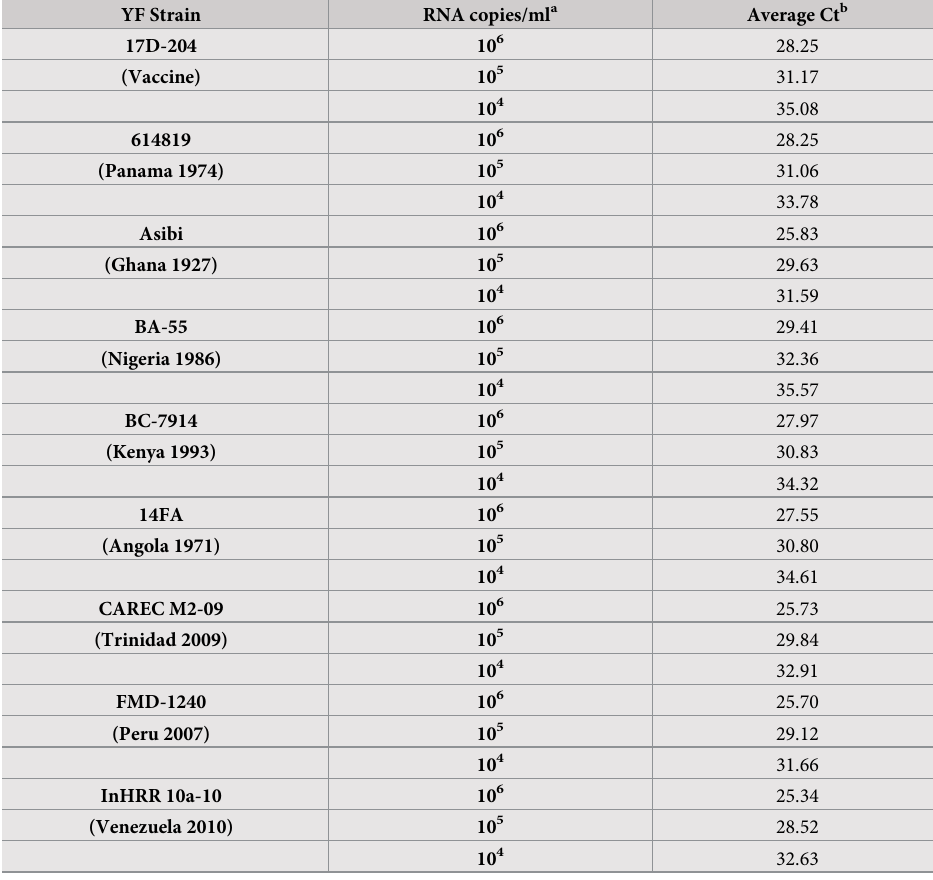
Table 4. Inclusivity of RealStar Yellow Fever Virus RT-PCR kit 1.0.